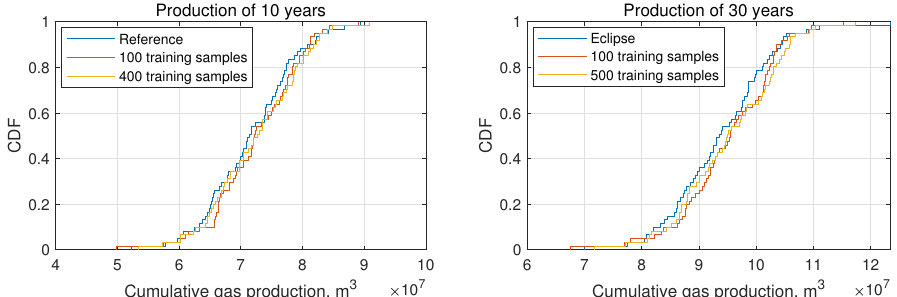
Figure 9. Probability distribution map of cumulative gas production in 10 and 30 years of shale gas production. Machine learning model is obtained by training 100 and 500 data sets,